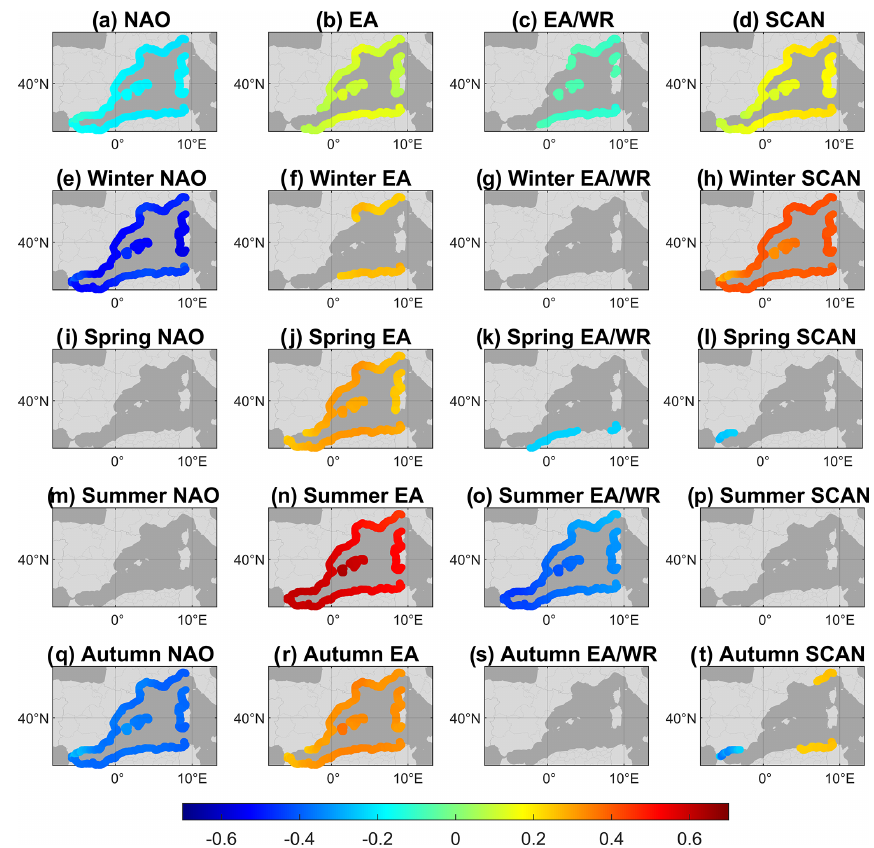
Figure 11. Seasonal and total maps of correlation coefficients between climate indices and the coastal sea level reconstruction for the period 1950–2019. Only correlations significant at the 95% level have been